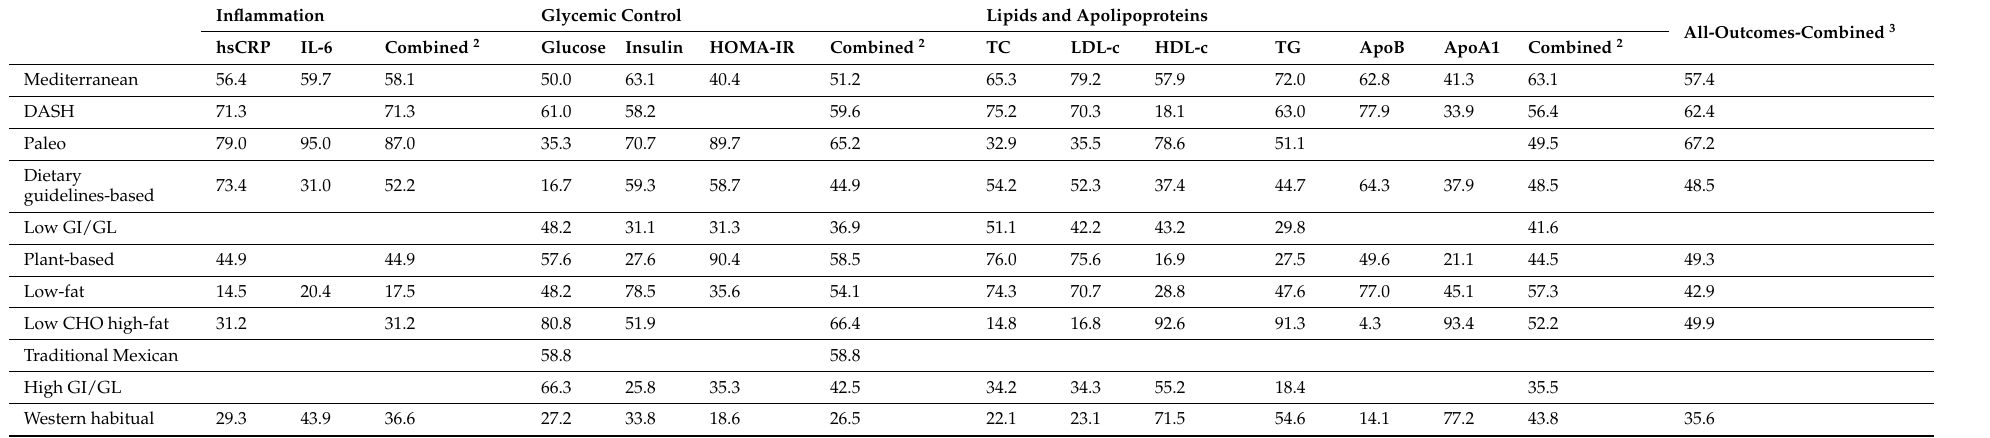
Table 2. SUCRA-values for each biomarker, category and for all outcomes combined 1